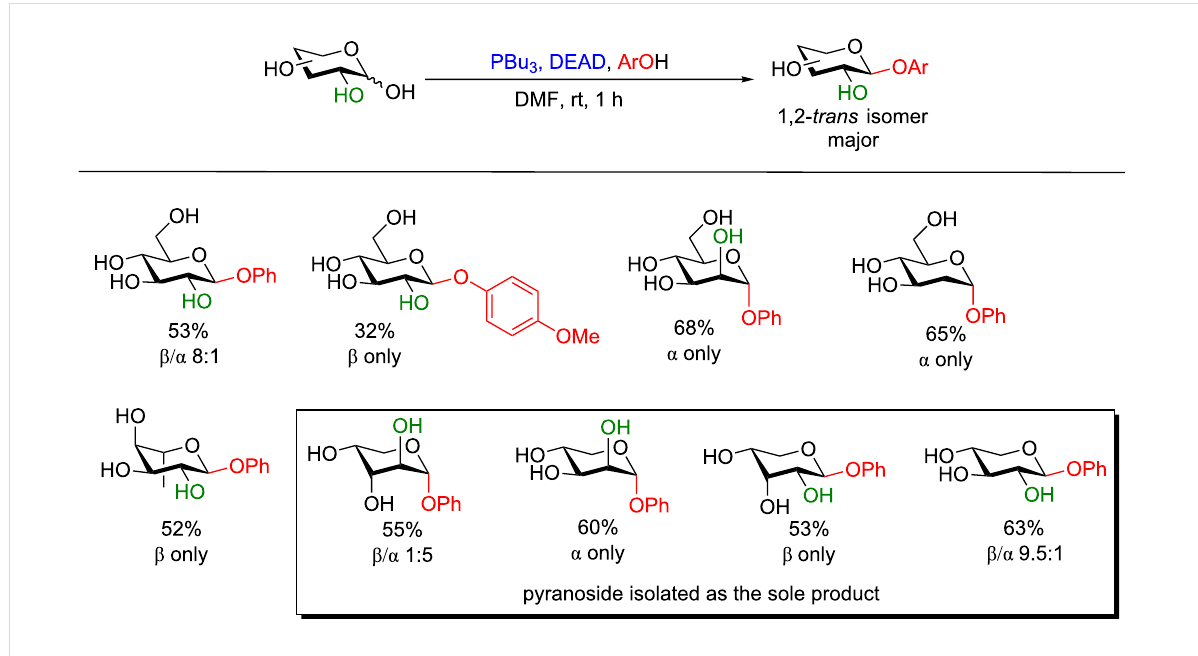
Figure 8: Protecting-group-free availability of phenolic glycosides under Mitsunobu conditions. DEAD = diethyl